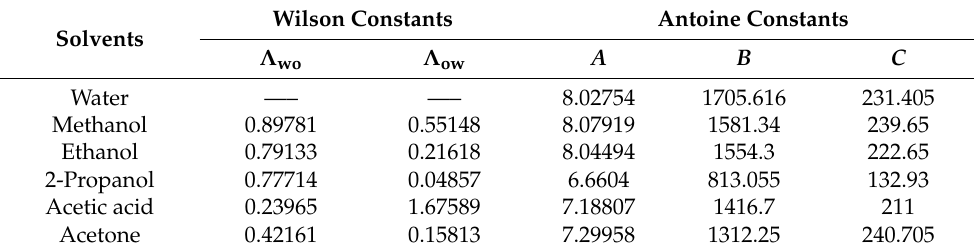
Table 1. Wilson constants and Antoine constants for organic solvents containing water [18].